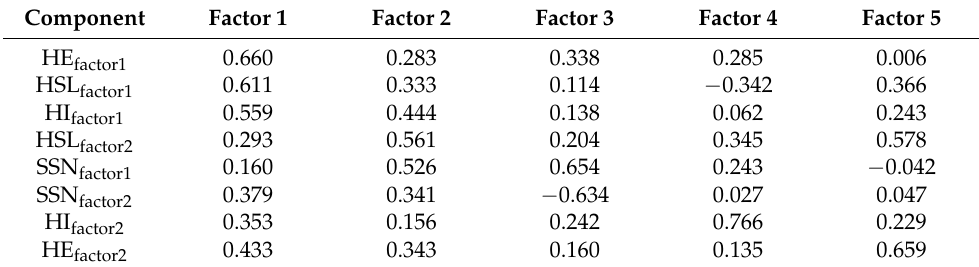
Table 11. Factor loadings of HI, HEC, HSoL, and SSN on the overall cyclone resilience index. Component Factor 1 Factor 2 Factor 3 Factor